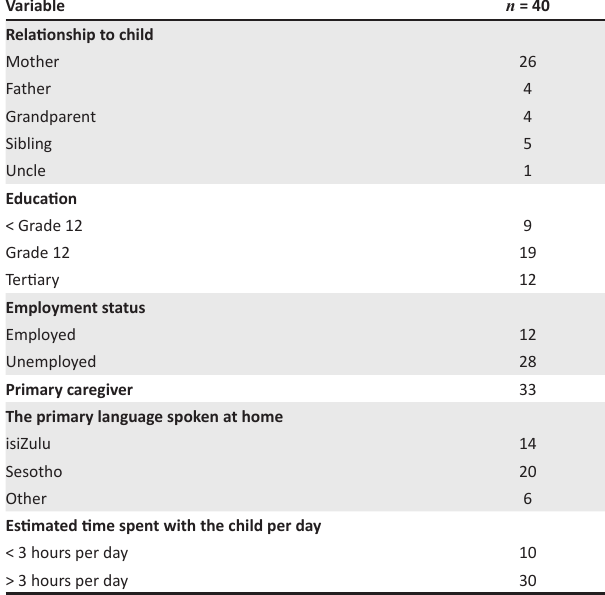
TABLE 1: Demographic information of participating